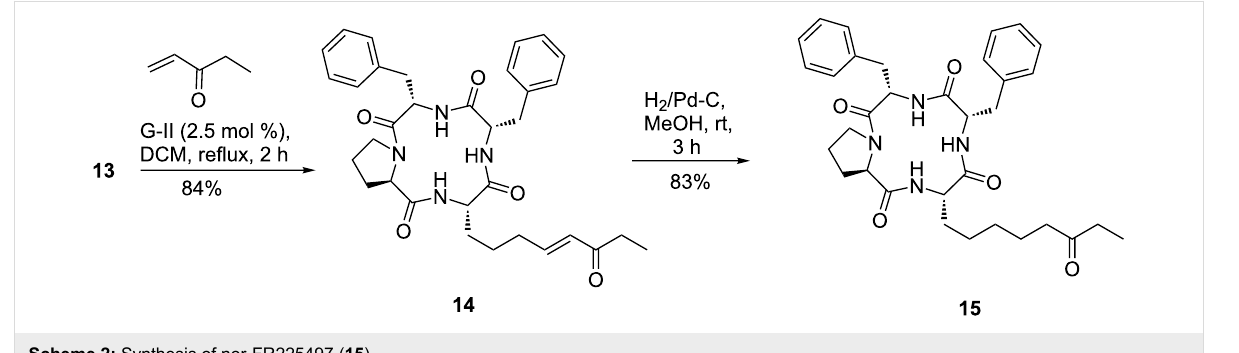
Scheme 1: Preparation of the macrocyclic template 13 .